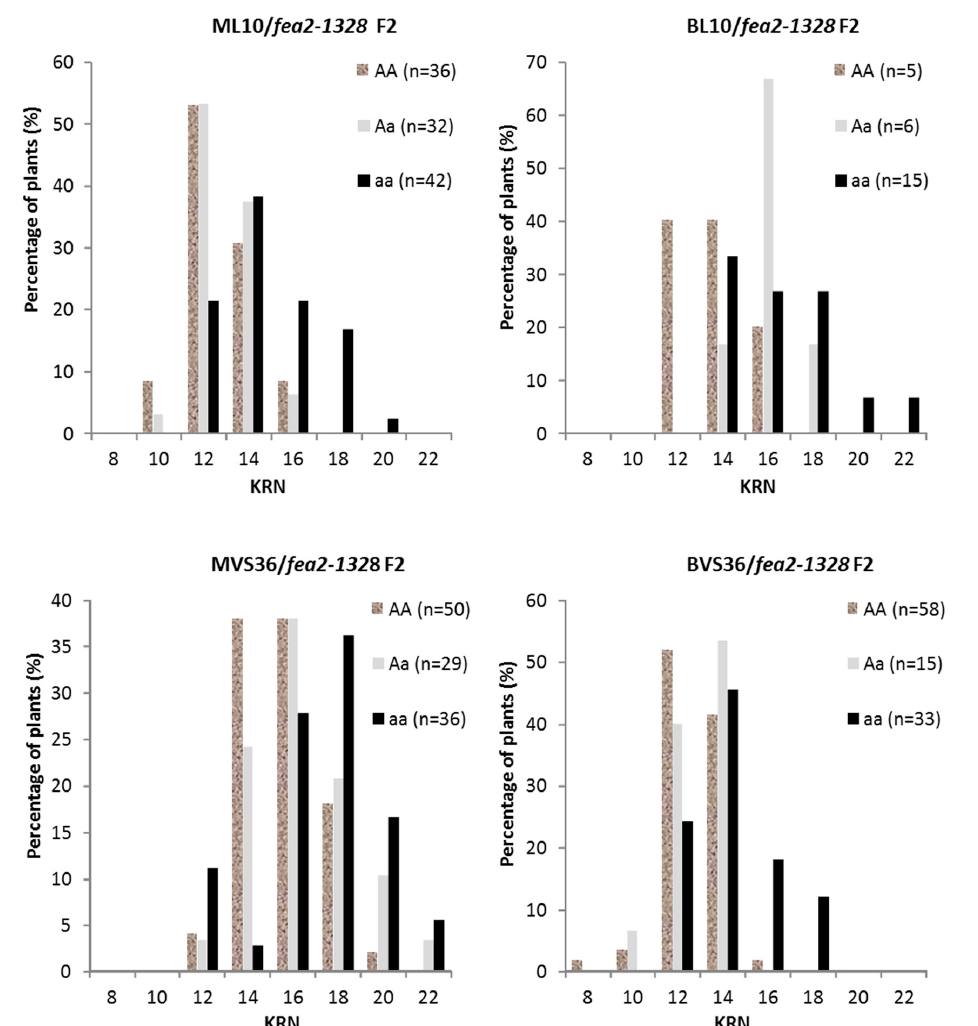
Figure 2. Segregation of phenotypes and genotypes in an F 2 generation in four recurrent parent backgrounds. AA, Aa, aa: plants that are homozygous wild-type, heterozygous, and homozygous mutant for the fea2-1328 allele, respectively. n : number of plants used for measurements. Genotyped plants were picked randomly for phenotyping; the number of plants indicated did not reflect the segregation ratio of different genotypic classes.